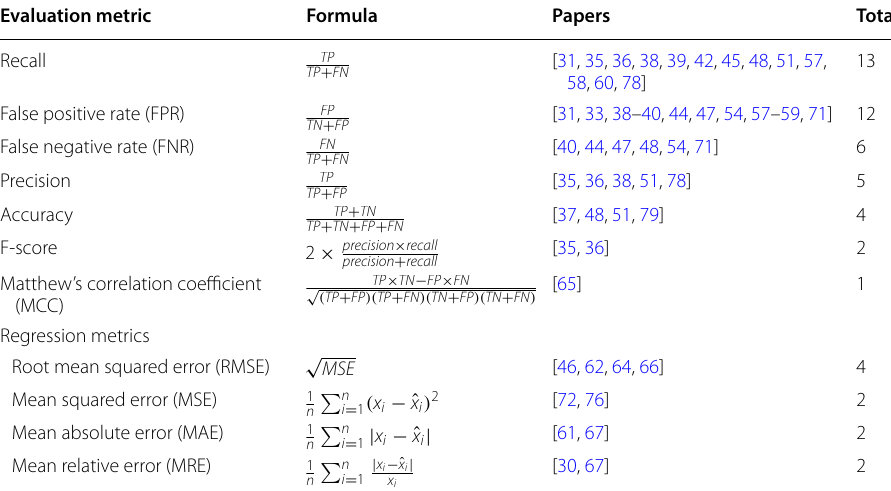
Table 10 Types of performance measures used in method evaluation for the 39 papers which has quantitative performance values and their respective formulas, papers and total number of papers, where TP true positive, TN true negative, FP false = = = positive, FN false negative, x i observed value or ground truth of sample i , ˆ x i = = = predicted value of sample i and n number of =